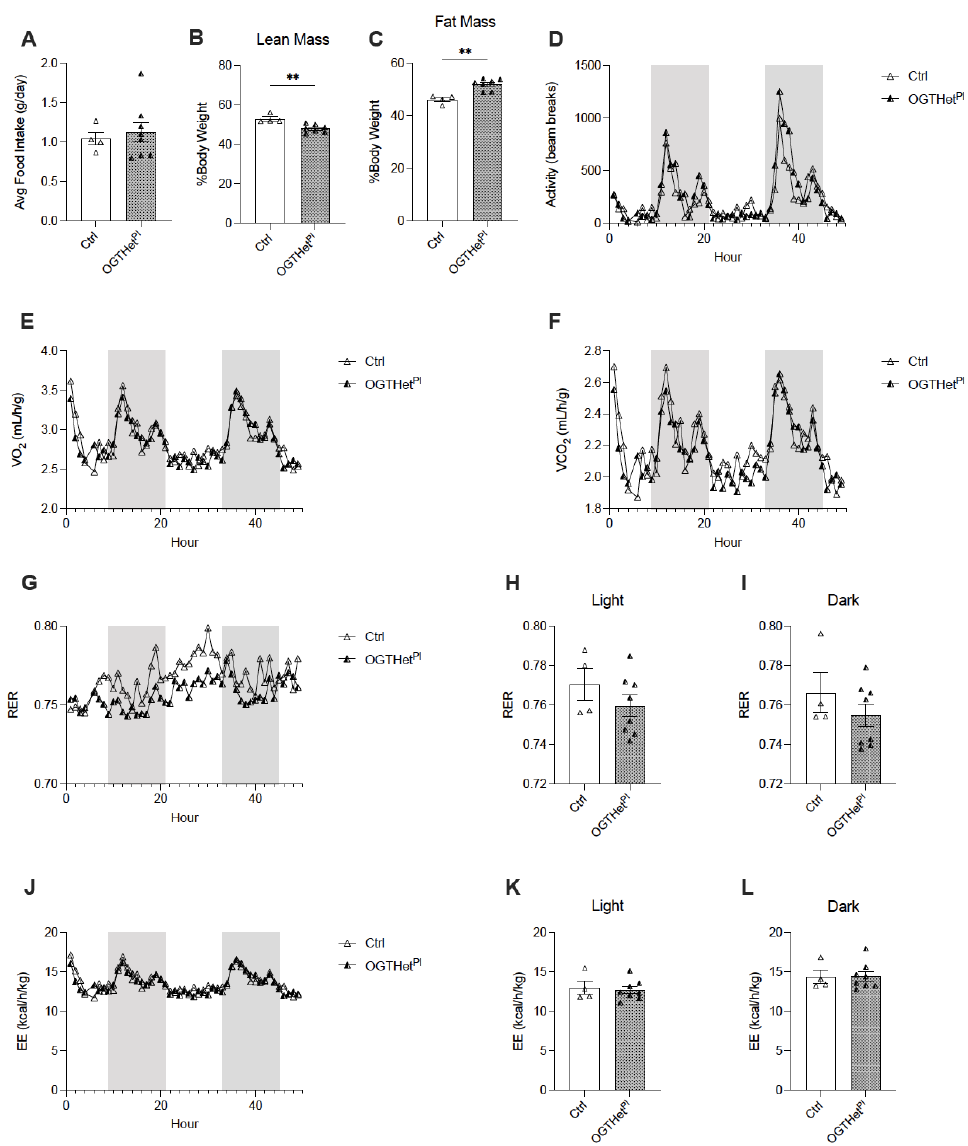
Figure 3. Increased fat mass and decreased lean mass for OGTHet Pl female mice but no difference in energy balance on HFD. ( A ) Daily food intake of HFD averaged over three days for female mice (n = 4, 8). ( B ) Lean and ( C ) fat mass of females (n = 4, 7) after 16 weeks HFD as assessed by EchoMRI. ( D ) Activity evaluated by beam breaks, ( E ) Volume of oxygen (VO 2 ) consumption, and ( F ) volume of carbon dioxide (VCO 2 ) generation over 72 hours (n = 4, 8) with12 h light and dark cycles. Dark cycle designated by the shaded region. ( G ) Respiratory exchange ratio (RER) over 72 hours (n = 4, 8) with12 h light and dark cycles. Dark cycle designated by the shaded region. ( H ) Averaged RER for light and ( I ) dark cycles (n = 4, 8). ( J ) Energy expenditure (EE) over 72 hours (n = 4, 8) with12 h light and dark cycles. Dark cycle designated by the shaded region. ( K ) Averaged EE for light and ( L ) dark cycles (n = 4–8). ( A – C , H , I , K , L ) was presented as mean ± SEM, unpaired t - test. ( D – F , G , J ) were presented as mean, two-way ANOVA. p values, ** p < 0.01.